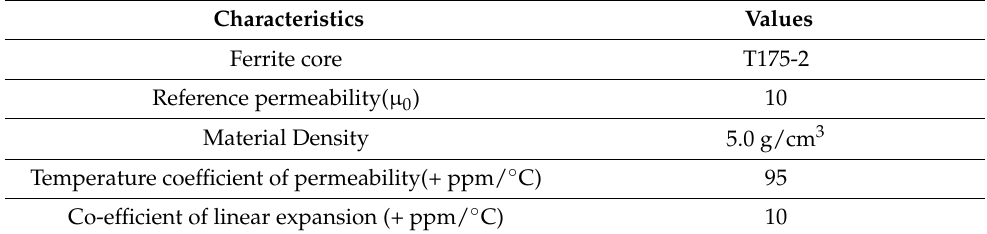
Table 1. Specifications of the ferrite core [40].